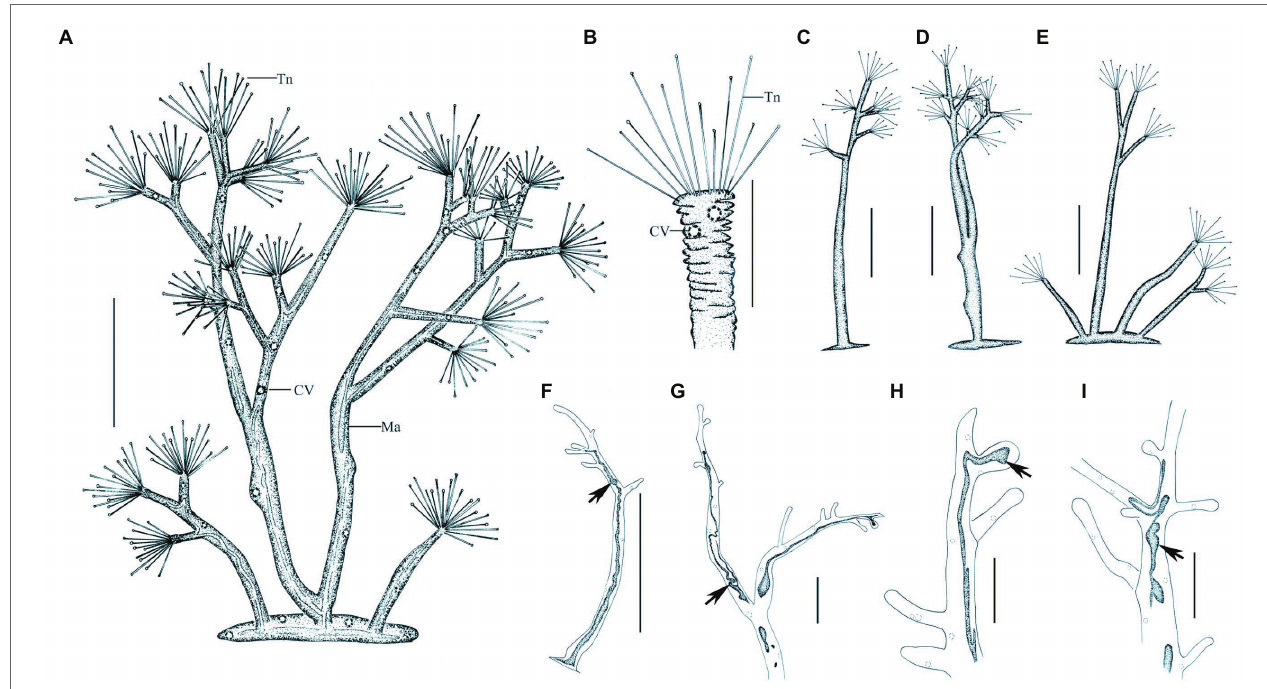
FIGURE 7 | Morphology of Dendrosoma radians Ehrenberg, 1838 from life (A–E) and after protargol staining (F–I) . (A) View of a typical individual. (B) Part of branch, to show some ends of branches can shrink. (C–E) View of different individuals in different periods of life history. (F–I) After protargol staining and Methyl Green-Pyronin Staining, arrows to show the different macronucleus. CV, contractile vacuole; Ma, macronucleus; Tn, tentacle. Scale bars = 250 μ m (A,D–E) , = 50 μ m (B–C,G–I) , = 500 μ m (F)